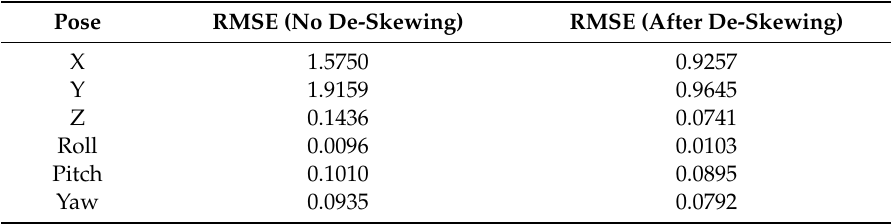
Table 3. Channel accuracy in the outdoor experiment.